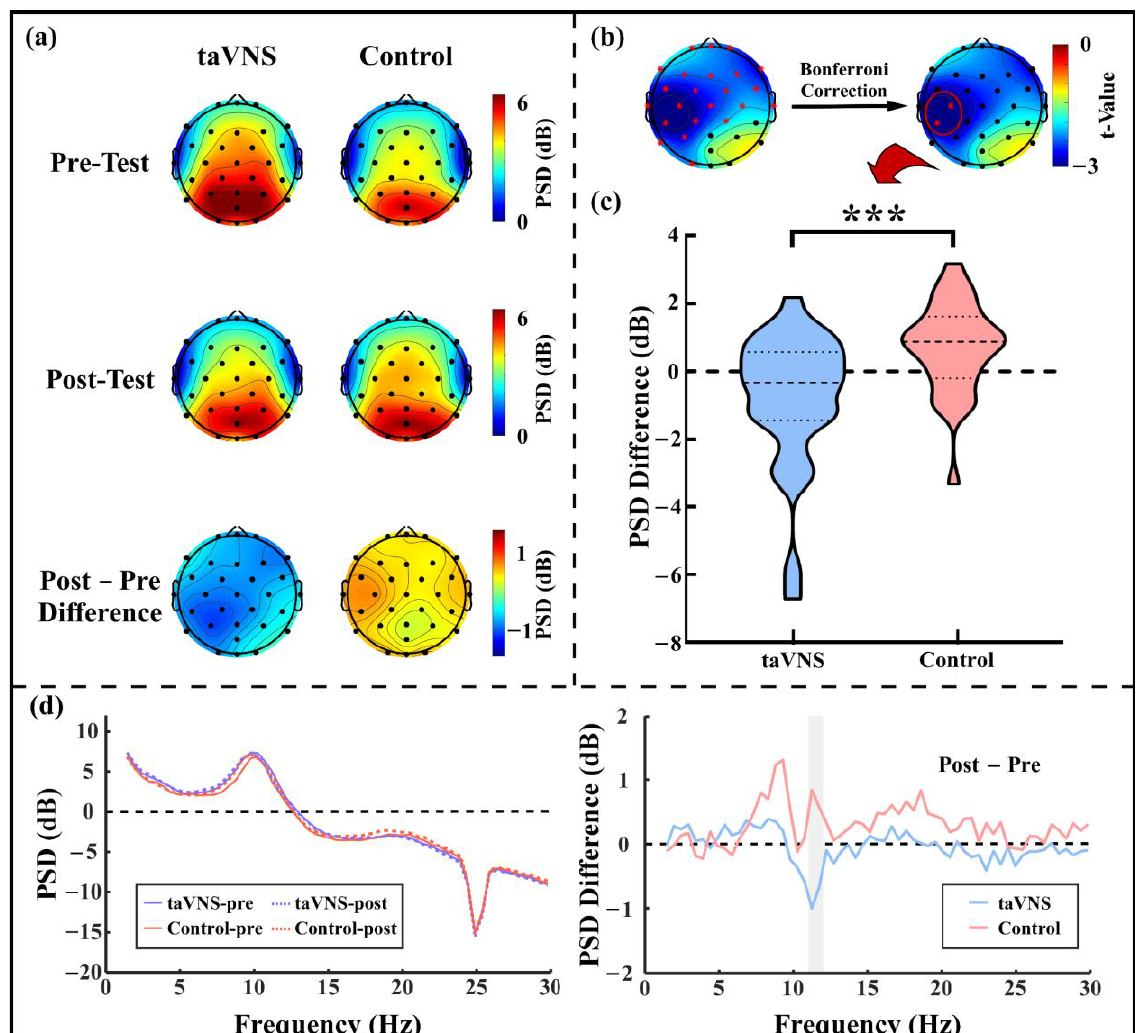
Figure 2. The high- α oscillation PSD under the close-eye resting state. ( a ) PSD topographies in the pre-test and post-test phases and the post – pre PSD difference topographies of high- α oscillations for the taVNS group and control group; ( b ) Topography of the t-value obtained from independent sample t-tests at each electrode for high- α oscillation PSD difference; ( c ) High- α oscillation PSD difference for the taVNS group and the control group; ( d ) Group average spectra and their post – pre differences at the C3 and CP5 electrodes for the taVNS group and the control group. Red asterisks in ( b ) represents significant differences between the taVNS group and the control group; the shadow region in ( d , right panel) represents the frequency range of high- α oscillations; *** p ≤ 0.001.